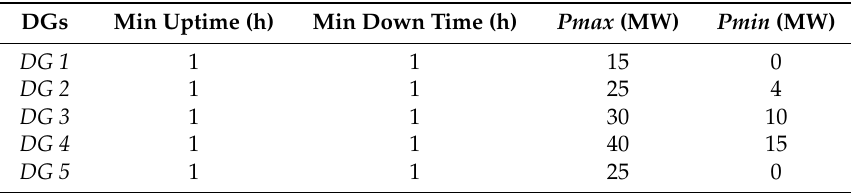
Table 1. Technical limits of the distributed generator (DG) units.